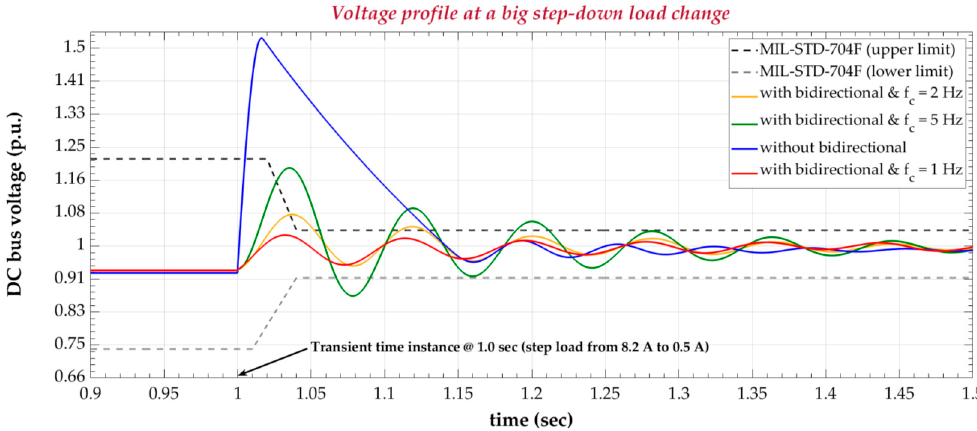
Figure 9. DC bus voltage response for a voltage swell, with the LPF cutoff frequency as a parameter.